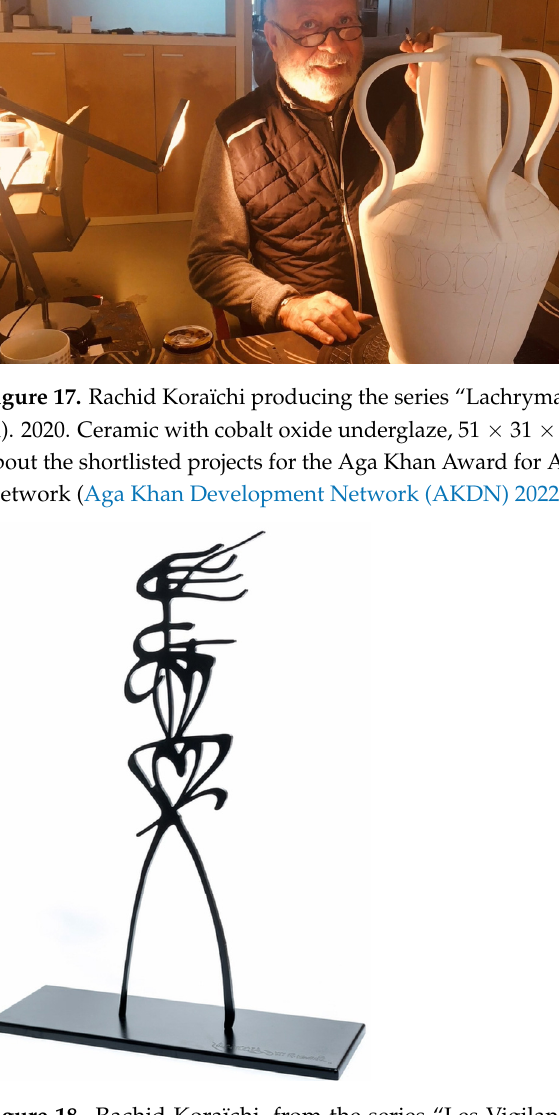
Figure 18. Rachid Koraïchi, from the series “Les Vigilants” (iii), 2020. Steel, 175 × 128 × 45 cm (RK5048). Screenshot from the film about the shortlisted projects for the Aga Khan Award for Architecture 2022, Aga Khan Development Network (Aga Khan Development Network (AKDN) 2022). © Rachid